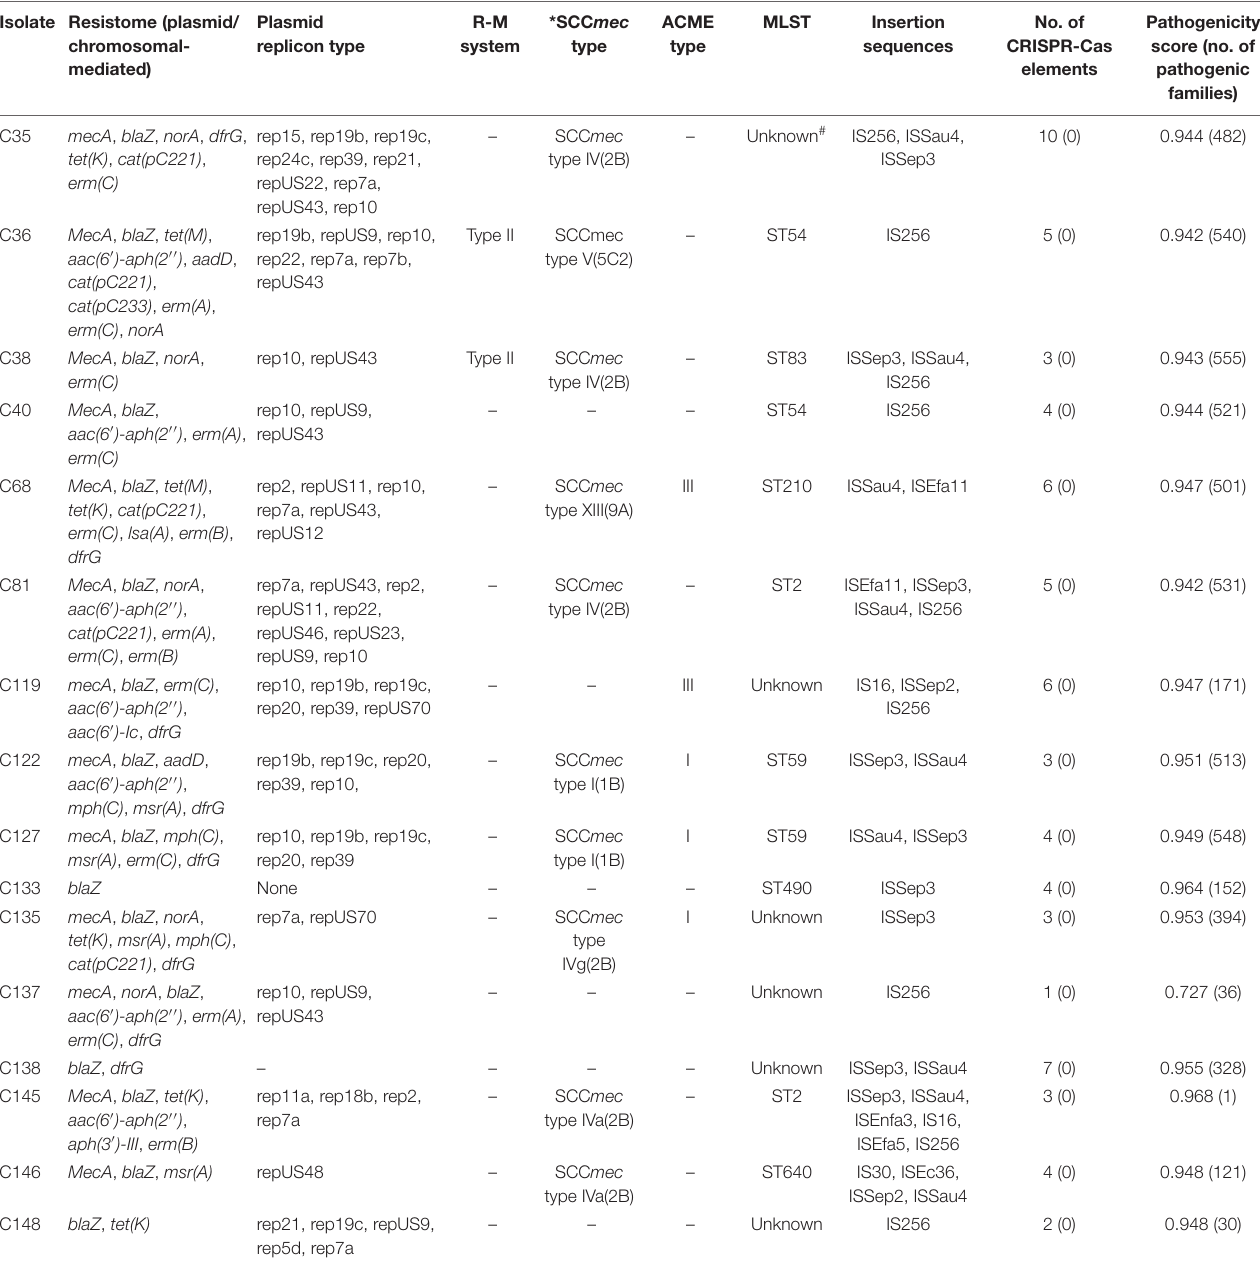
TABLE 3 | Genotypic characteristics of the MRSE isolates. Isolate Resistome (plasmid/